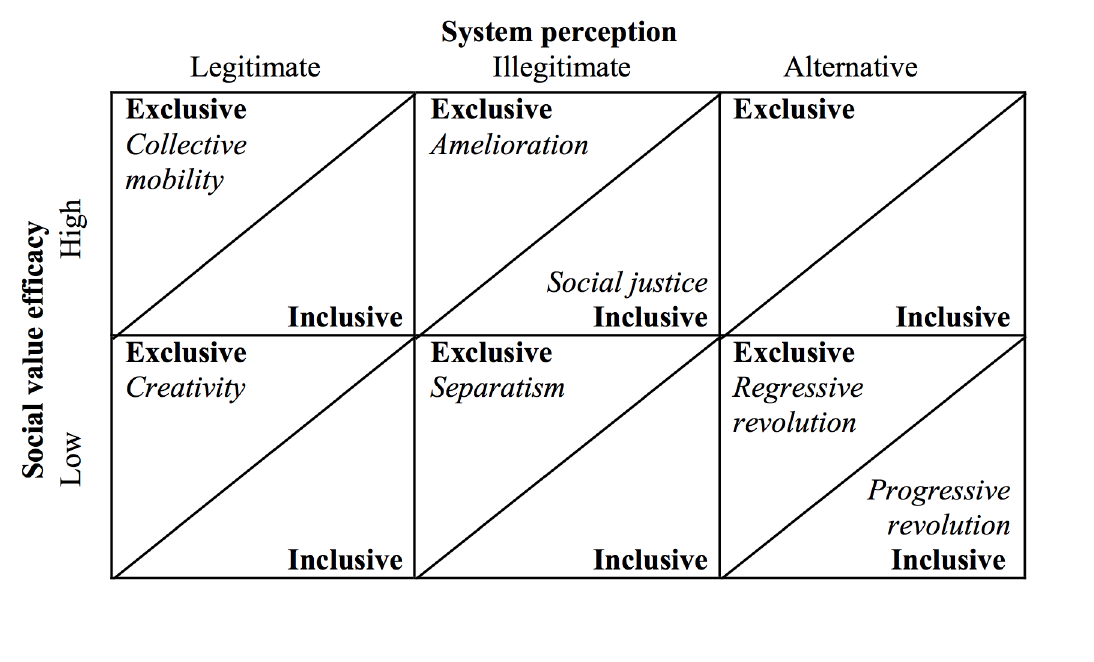
Figure 1. Typology of social change